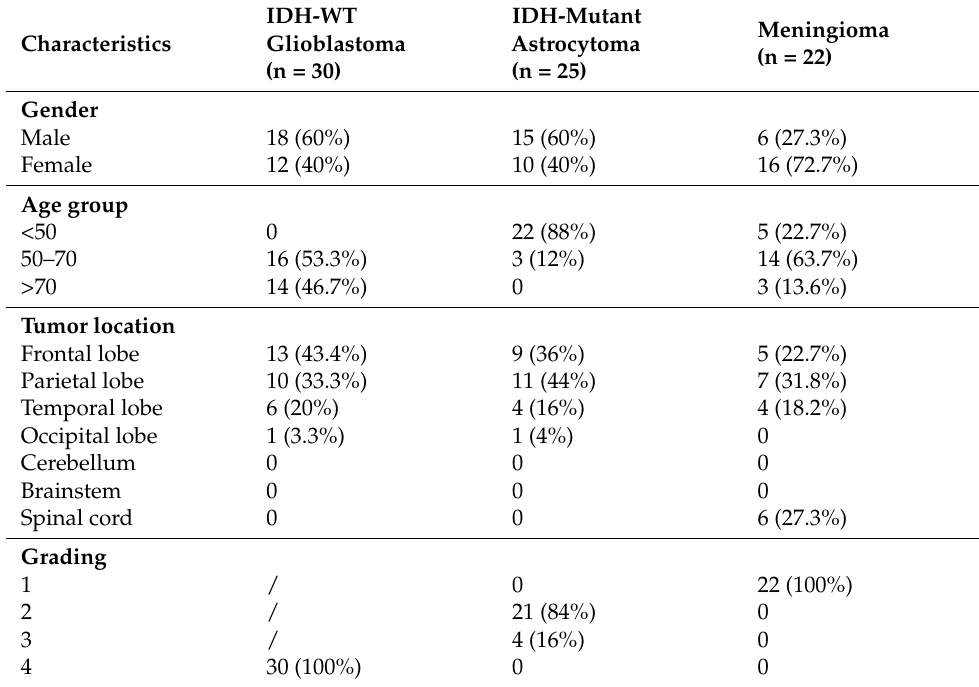
Table 1. Patients